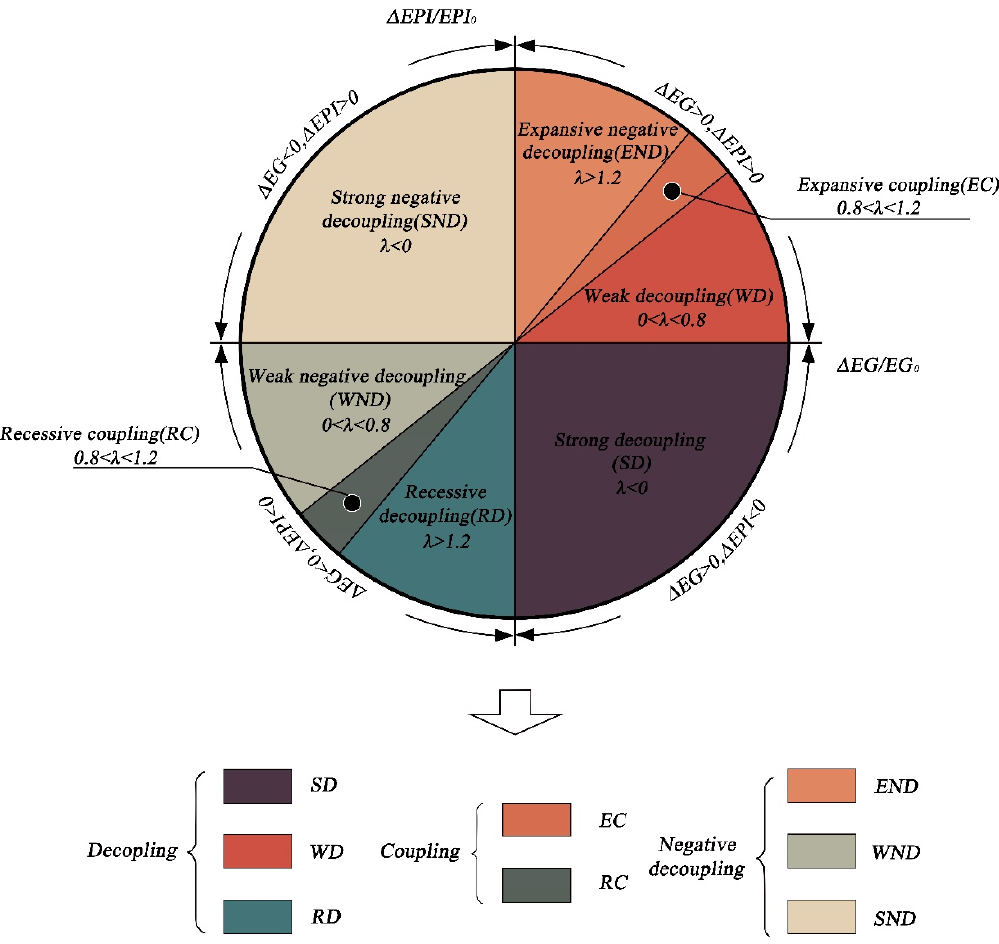
Figure 4. Classification of decoupling states in the Tapio model.